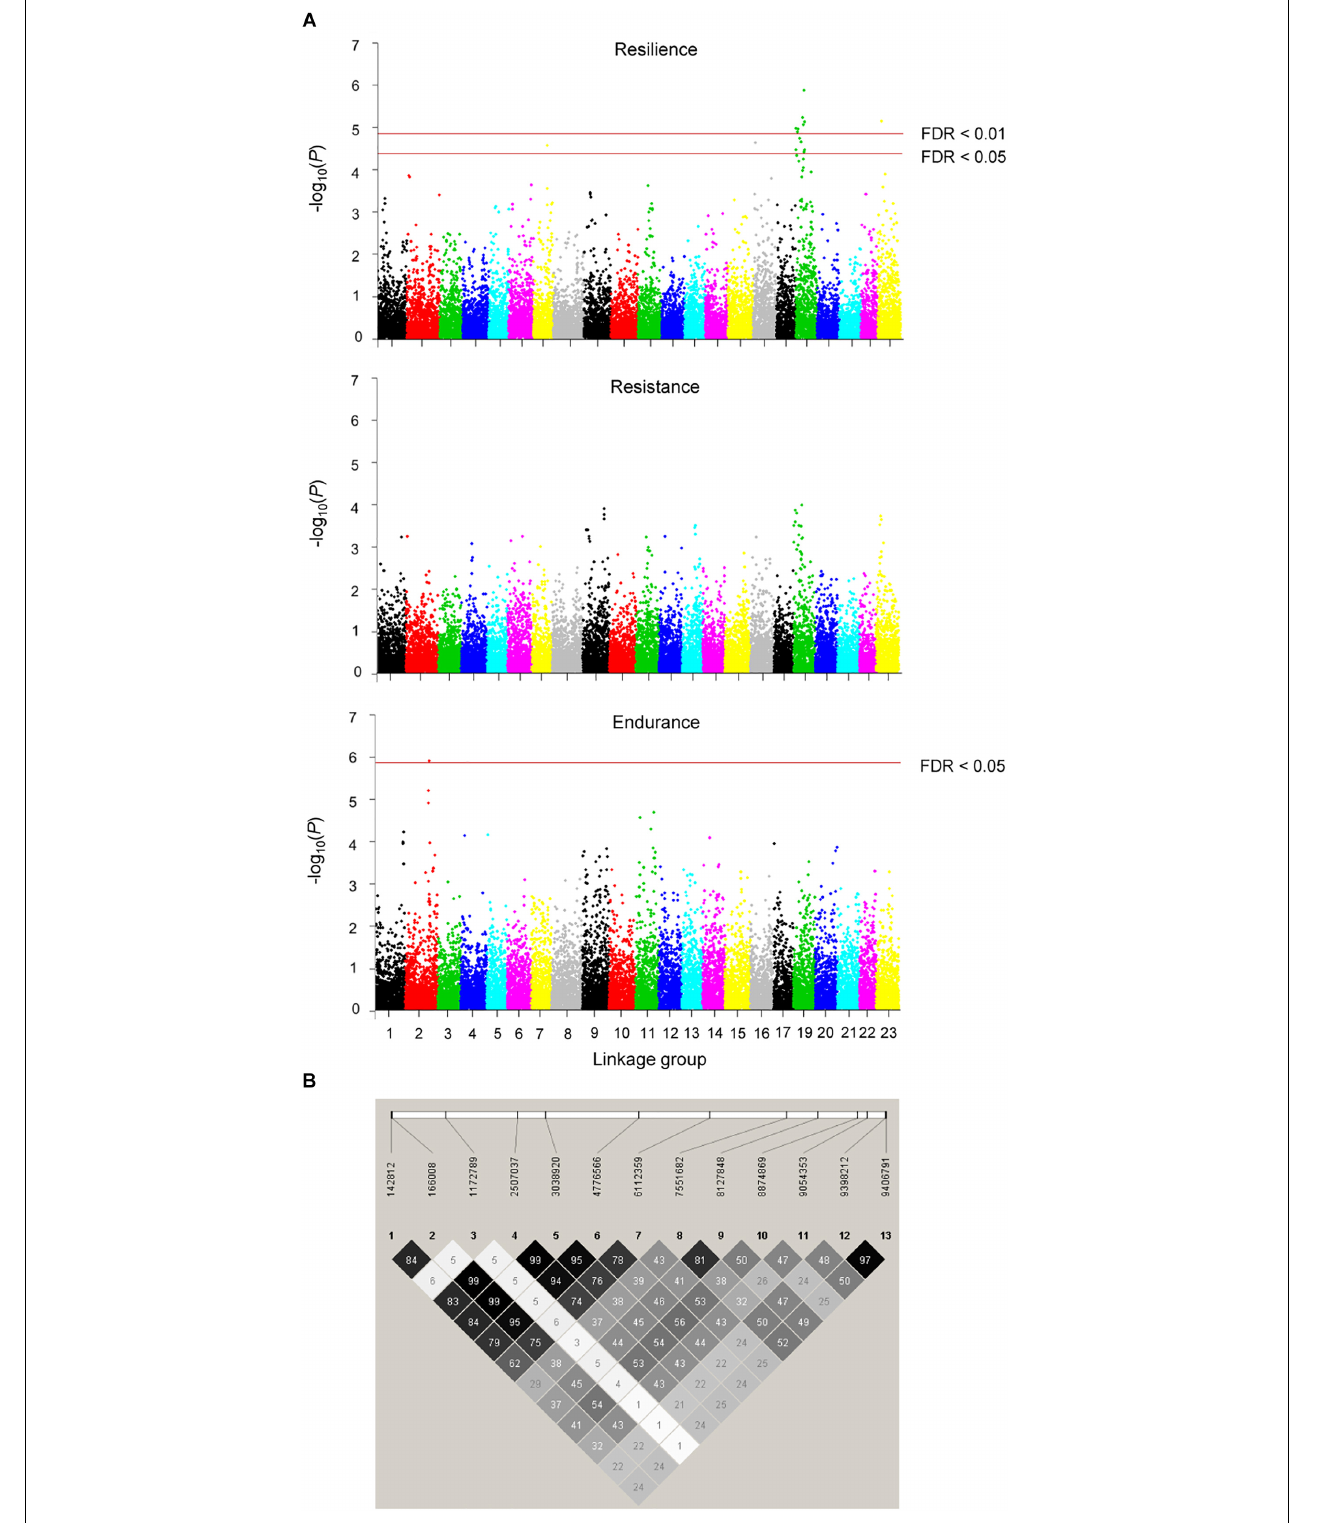
FIGURE 4 | Manhattan plots resulting from the GWAS for resilience, resistance, and endurance at two different false discovery rate thresholds (FDR = 1 or 5%) (A), and linkage disequilibrium ( r 2 ) plot for the 13 significant SNPs identified in the 9.3 Mb candidate QTL region for resilience (B) . Colour intensity of diamonds is proportional to r 2 values, which are given in